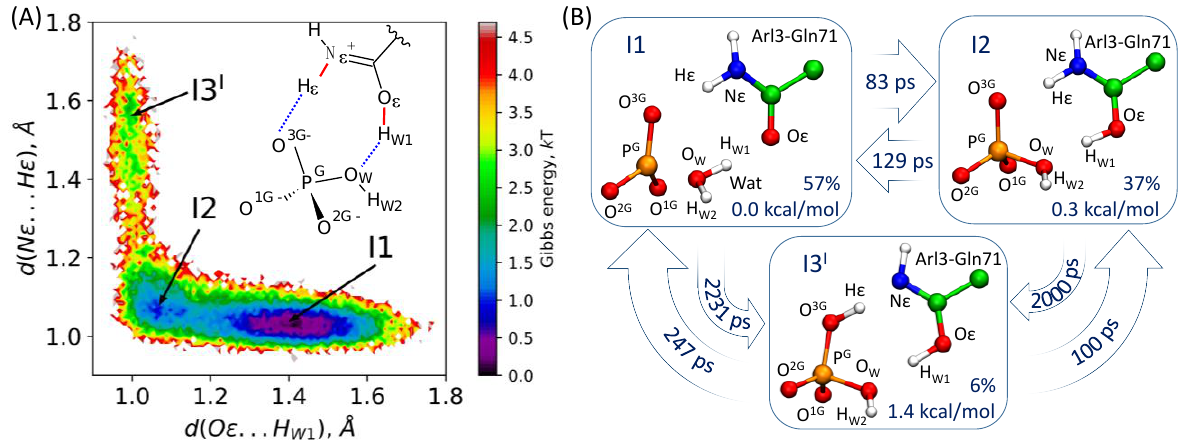
Figure 6. ( A ) Projection of the QM/MM MD data on the two interatomic distances d(H W1 …Oε) and d(Hε…Nε); ( B ) Transitions between macrostates (I1, I2 and I3 I ) obtained in the MSM analysis. Relative populations of the corresponding macrostates and their relative energies are indicated in the boxes. Values in arrows report the transition times.